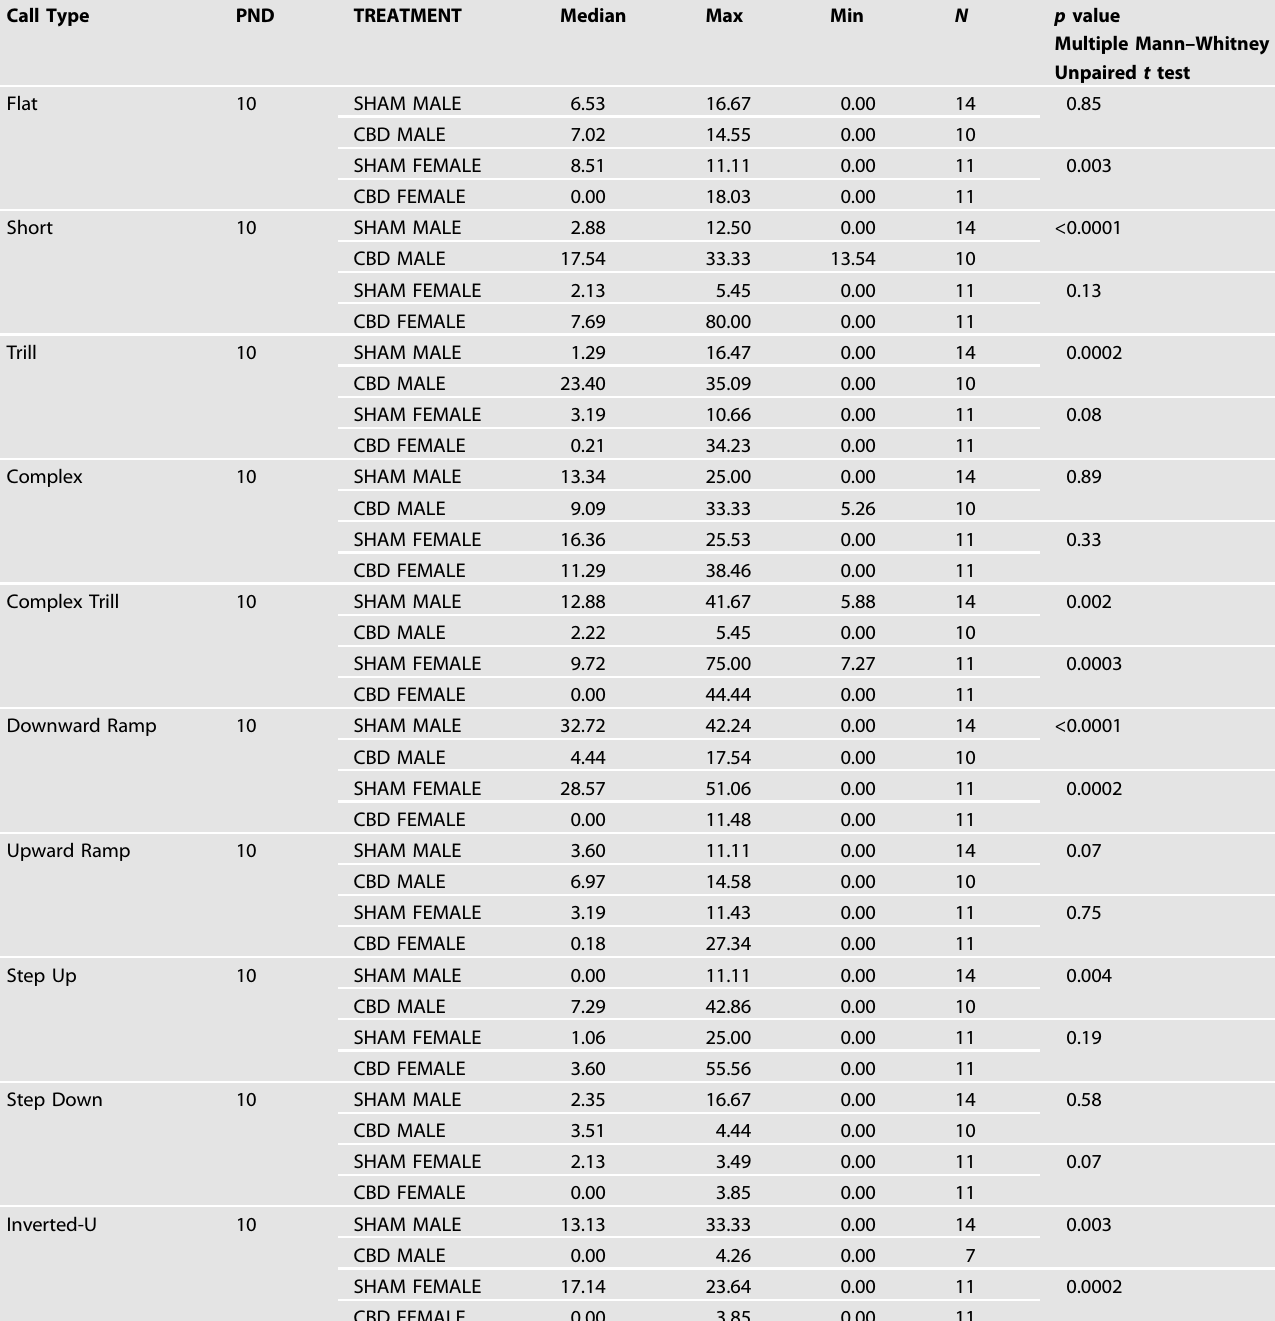
Table 3. Call type pro fi le is altered in a sex-speci fi c manner in CBD-exposed pups. Call